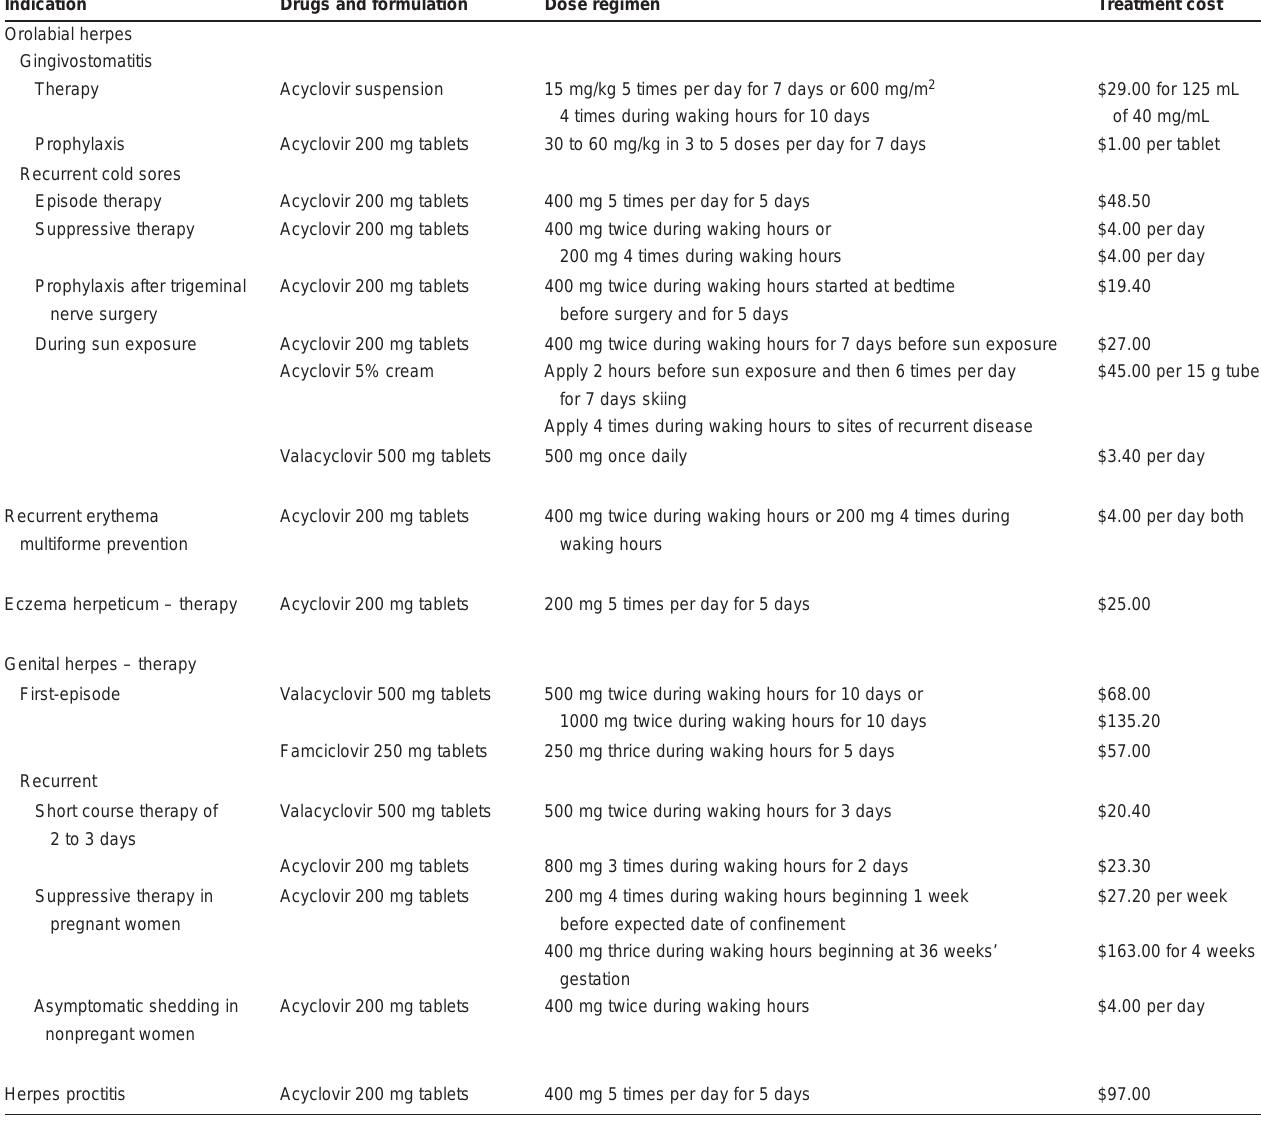
TABLE 3 Thirteen off-label indications for drug therapy of mucocutaneous herpes simplex virus infections in the normal host